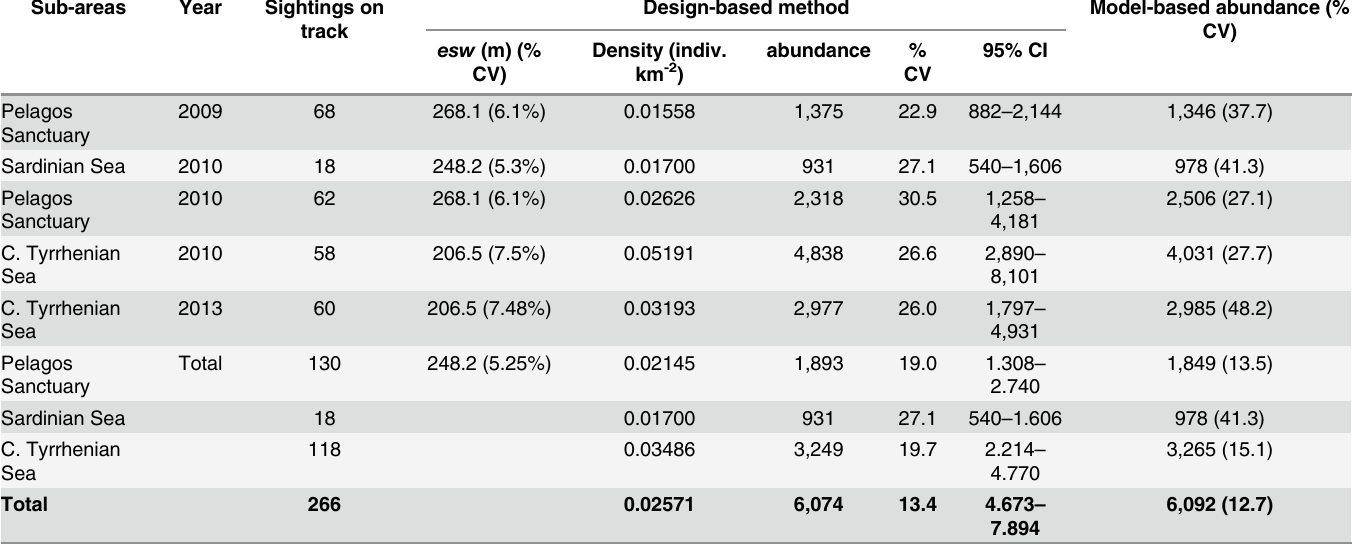
Table 3. Density and uncorrected abundance estimates for the three sub-areas, obtained with design-based and model-based methods. Esw : effective strip width.